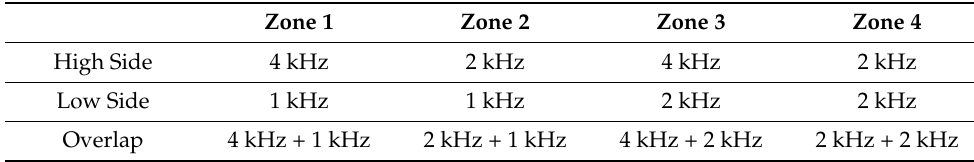
Figure 7. Frequency characteristics of the High Side of the transmitter: ( a ) High Side output; ( b ) High Side frequency; ( c ) High Side FFT. Table 1. Comparison of frequency variation